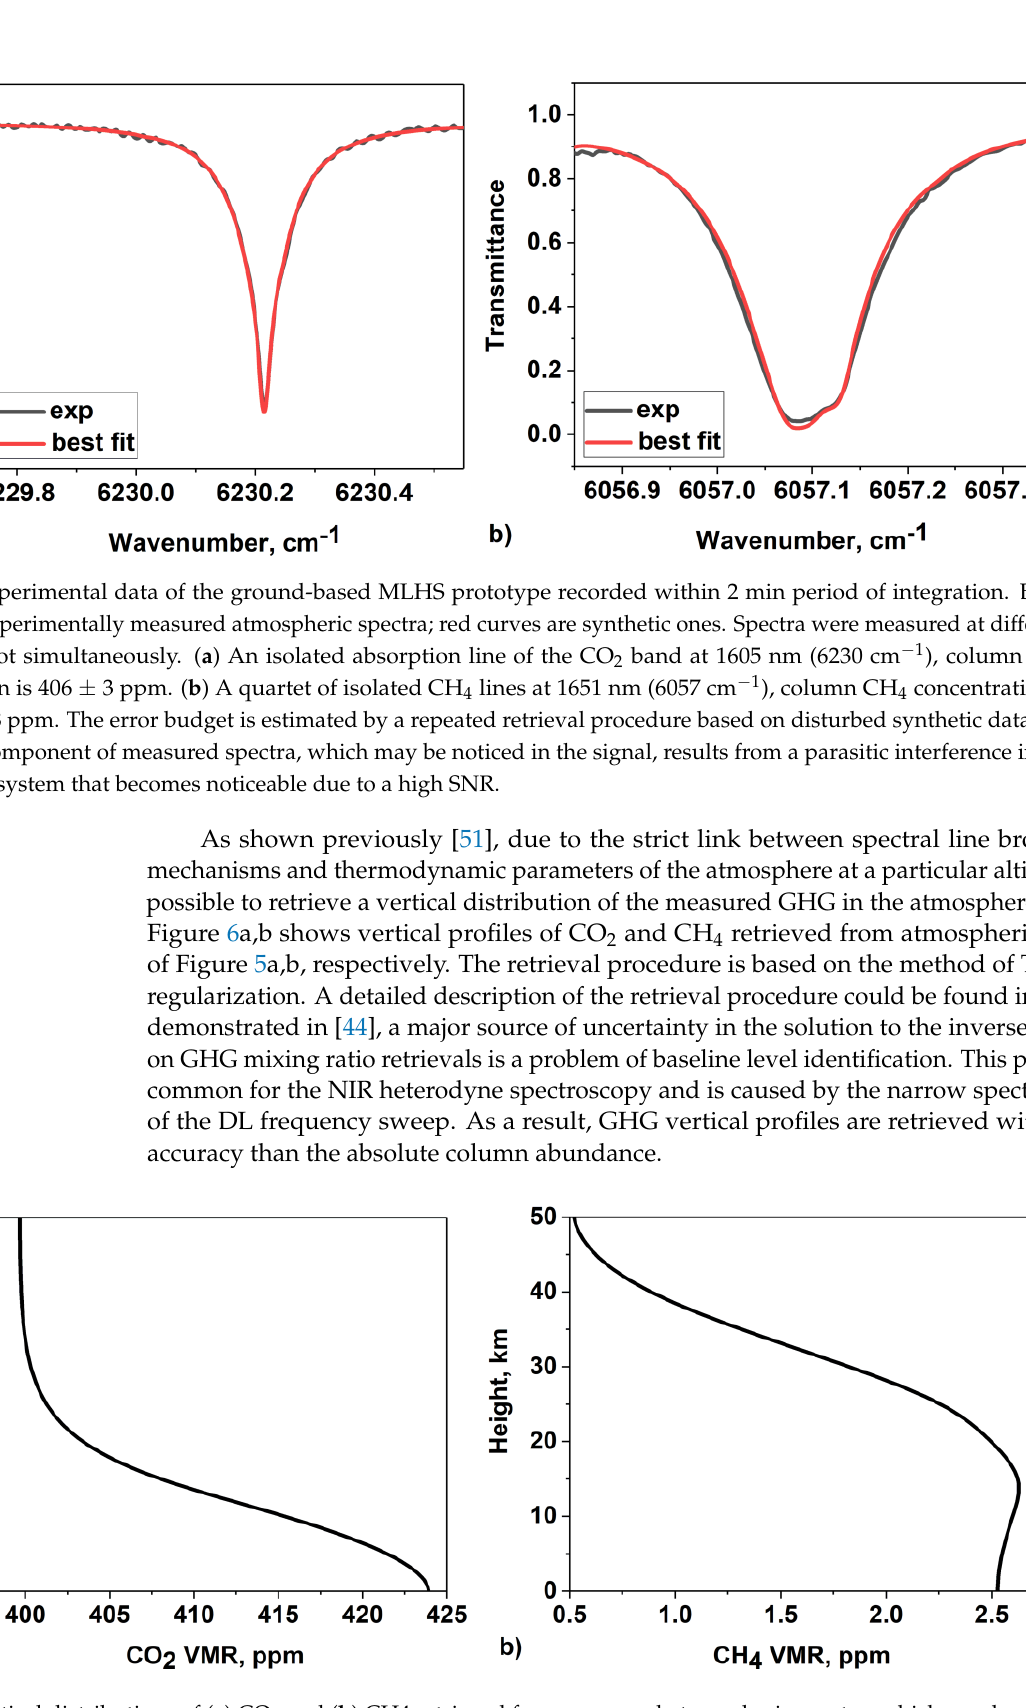
mospheric spectra of Figure 5a,b, respectively. Black curves are reanalysis data taken from [49]. Figure 7. Vertical profiles of the wind speed projection on the line of sight (red curves) ( a , b ) retrieved from measured atmospheric spectra, which are demonstrated in Figure 5a,b, respectively. Black curves are the reanalysis data. The re- trievals’ pre cision is about 3 – 5 m/s with a vertical resolution of half of the height scale. (For interpretation of the refer- ences to color in this figure, the reader is referred to the web version of this article). Finally, before introducing the concept of the 2U spaceborne MLHS, it is necessary to estimate the level of SNR, which can be achieved at shorter periods of signal integra- tion. Figure 8a,b presents atmospheric transmittance spectra measured in the vicinity of wavelengths 1605 and 1651 nm. These spectra (black curves) were recorded in a multi- channel mode within one second integration time and have an SNR of about 50. Spectra with such SNR level are characterized by clearly recognizable line shapes, whose analysis enables retrievals listed above.